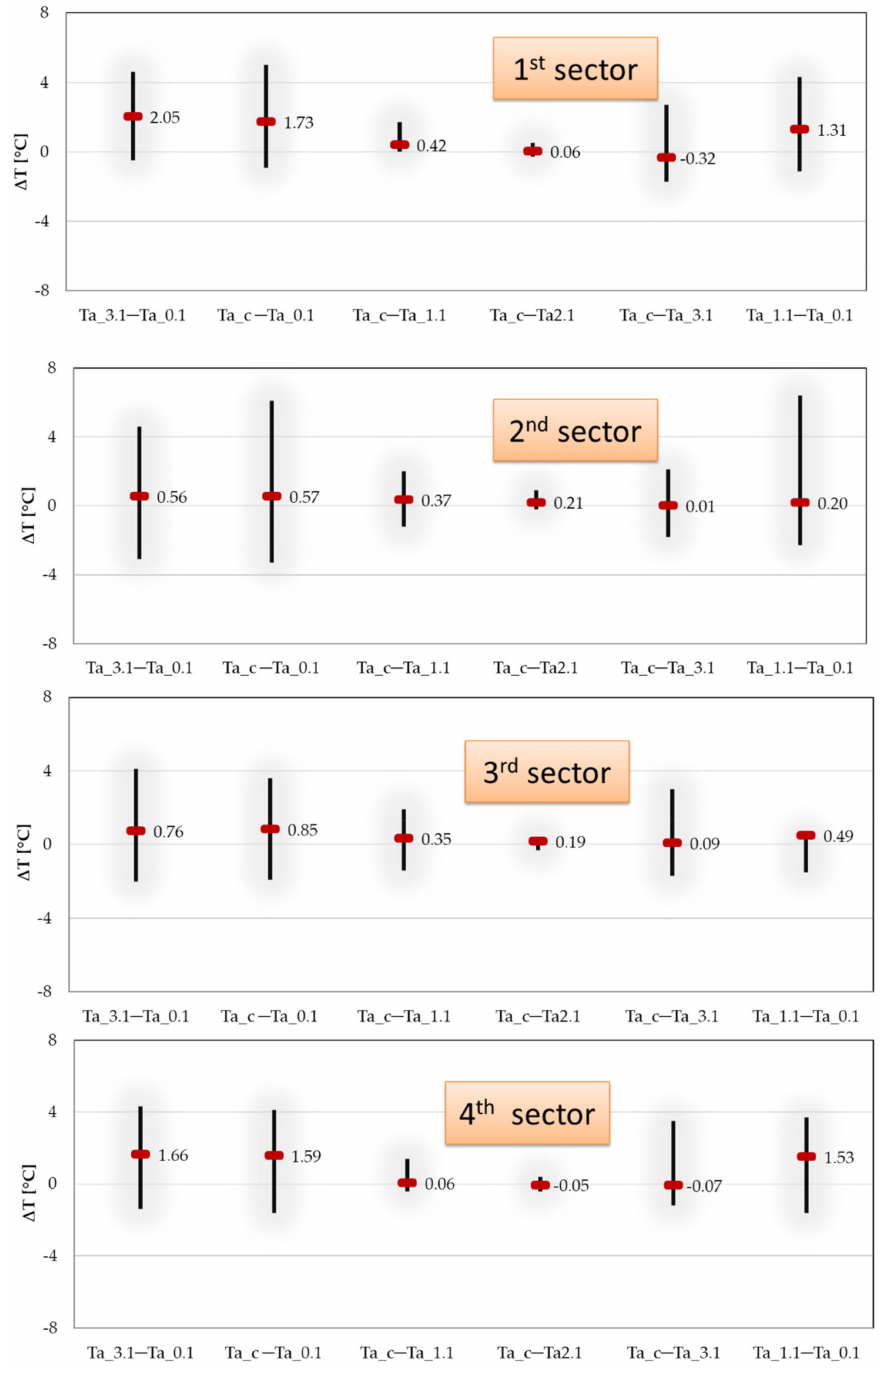
Figure 15. Extreme values for vertical temperature difference: radiant floor system. The temperature difference for heights 1.1 m and 0.1 m was usually lower than in the previous case, and only in a few cases did it exceed the limit value (3 ◦ C). More in detail, it happened only on 16 February around 12:00 when the effect of solar gains tended to locally heat the place where the sensor was placed; extreme values were recorded in the 3rd sector (+6.40) and in the 1st sector (+4.30 ◦ C). For all other days, this difference varied between 0.2 ◦ C and 1.5 ◦